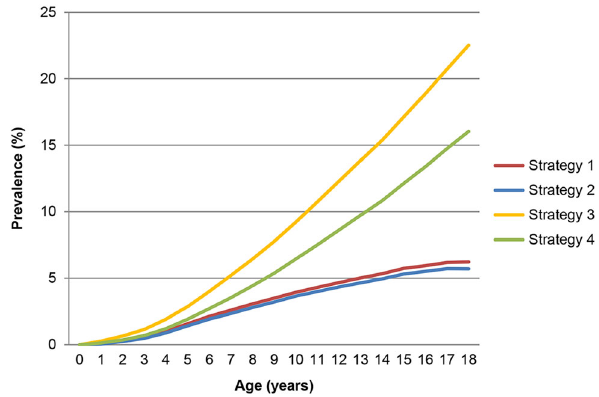
Fig. 1 Prevalence by age for atopic eczema